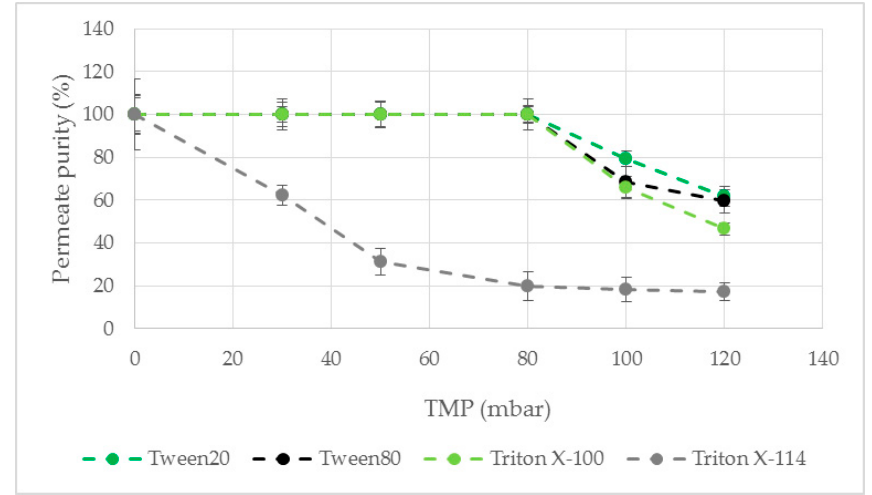
Figure 4. Permeate purity as a function of the TMP. A hydrophobic PP membrane was modified. ATPS4, Δ P = 30 mbar, Q = 16.7 mL/min. PP: polypropylene.